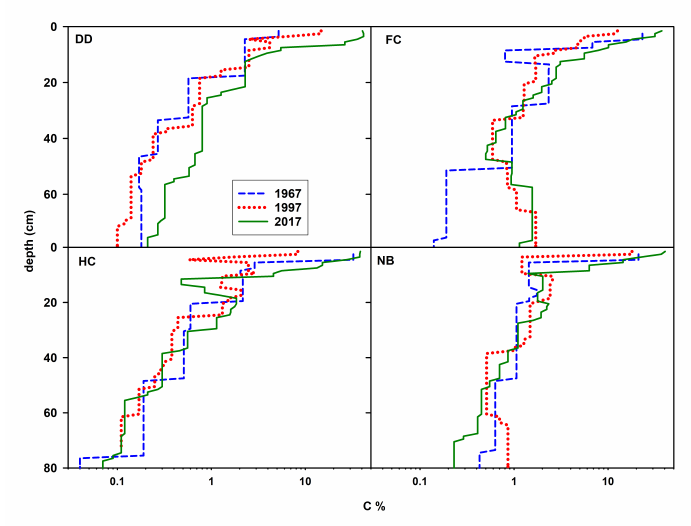
Figure 5. Soil organic carbon concentration profiles to a depth of 80